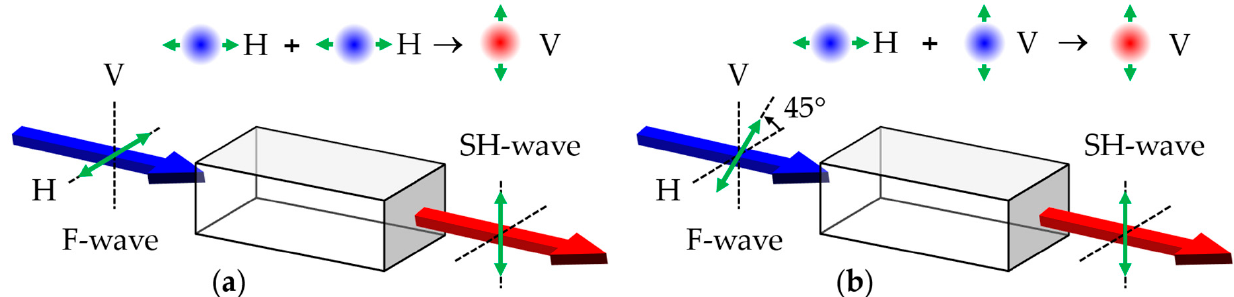
Figure 1. Schematic diagrams showing the polarization relationships of fundamental (F) and second harmonic (SH) waves for ( a ) Type I and ( b ) Type II. V and H represent vertical and horizontal polarization directions, respectively.